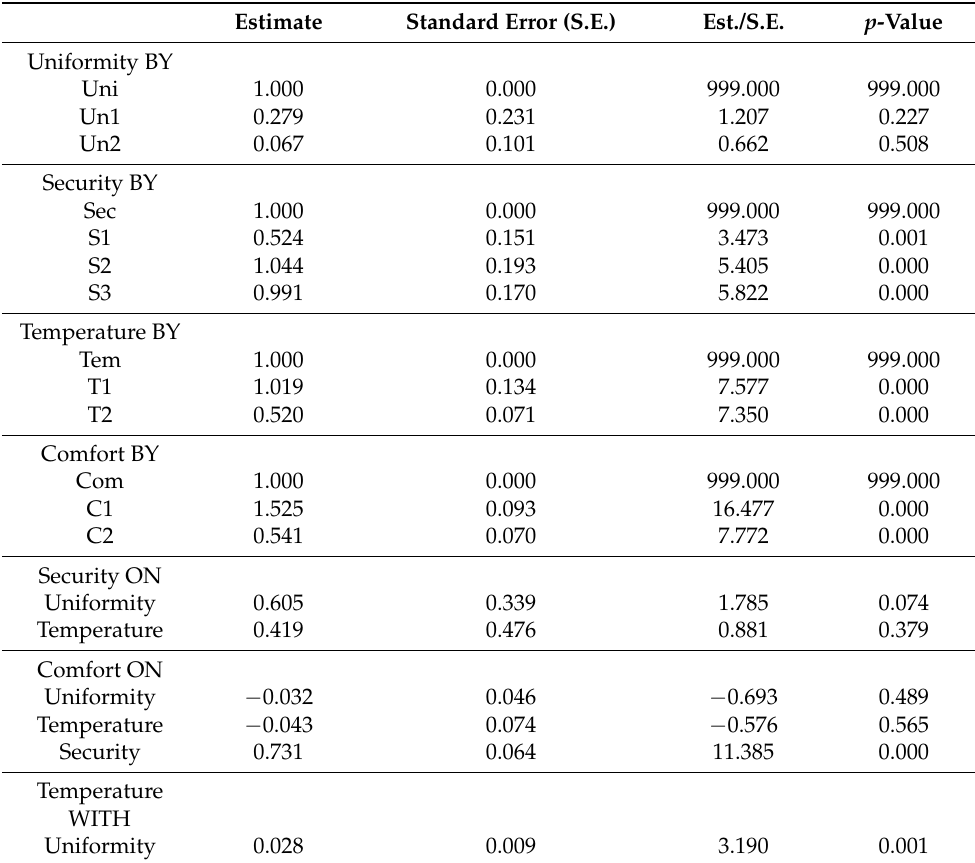
Figure 15. Comfort evaluation model of public space lighting in typical residential areas of Beijing.